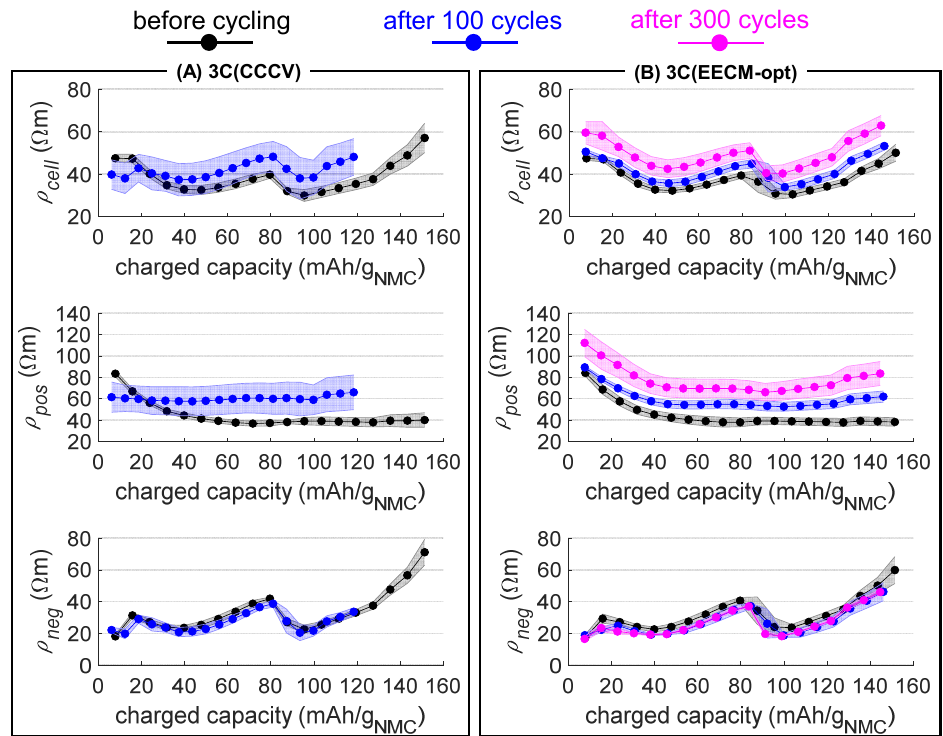
Figure 8. Specific cell and electrode resistances at different cycle counts between 5–95% SOC. ( A ) specific cell and electrode resistances for 3C(CCCV) cycling. ( B ) specific cell and electrode resistances for 3C(EECM-opt) cycling. The cycling of both fast-charging strategies leads to increased positive electrode resistances whereas the negative electrode resistances do not change significantly —even for 3C(CCCV), which results in lithium-plating.